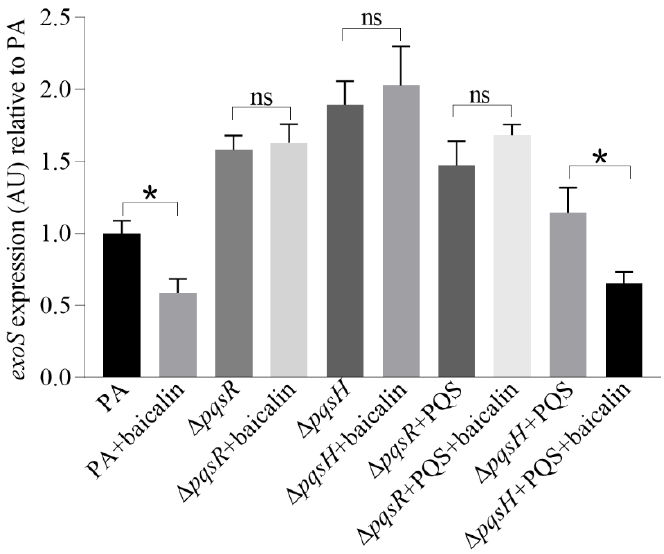
Figure 8. Relative expression levels of exoS in PAO1, ∆ pqsR and ∆ pqsH under different conditions. The activity of exoS promoter in soft agar medium was measured as described in Materials and Methods. Baicalin was added at 250 µg/mL. PQS was added at 1 µg/mL. After overnight incubation at 37 °C, light production of the reporter strain was recorded by a LAS-3000 imaging system (Fuji Corp, Tokoyo, Japan). The relative promoter activity was evaluated by the software multi gauge version 3.0. AU strands for Arbitrary Unit, a unit to measure the amount of chemiluminescence recorded by LAS-3000. It signifies the relative density value accumulated as linear data by a CCD camera in the image surface. Averages of triplicate experiments ± standard errors of the means are shown. The results shown are representative of three independent experiments with similar trends. * significant difference ( p < 0.05) ns, no significant